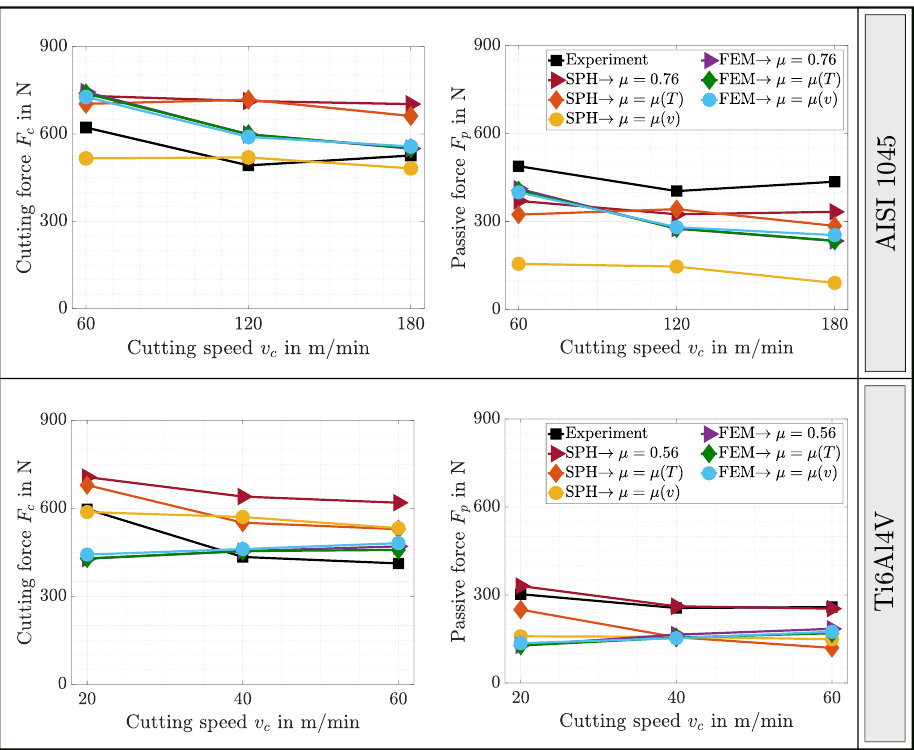
Figure 6. Comparison of measured and predicted forces for t u = 0.10 mm at different cutting